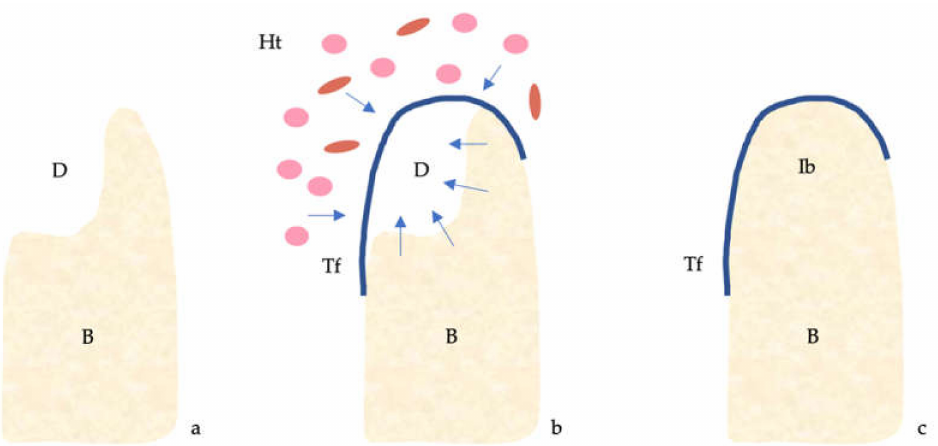
Figure 1. Guided bone regeneration (GBR) mechanism. ( a ) Bone defect. ( b ) The titanium barrier prevents the penetration of epithelial cells and fibroblasts and allows access to the defect of osteogenic and stem cells originating from the native bone. ( c ) Regeneration of the bone defect. Abbreviations: B, bone; D, defect; Ht, healing tissue; Ib, immature bone; Tf, titanium